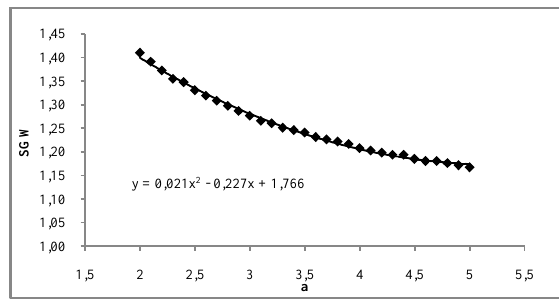
Fig. 28. Chart of S GW parameter a and quadratic function. Figure 28 shows that S GW parameter